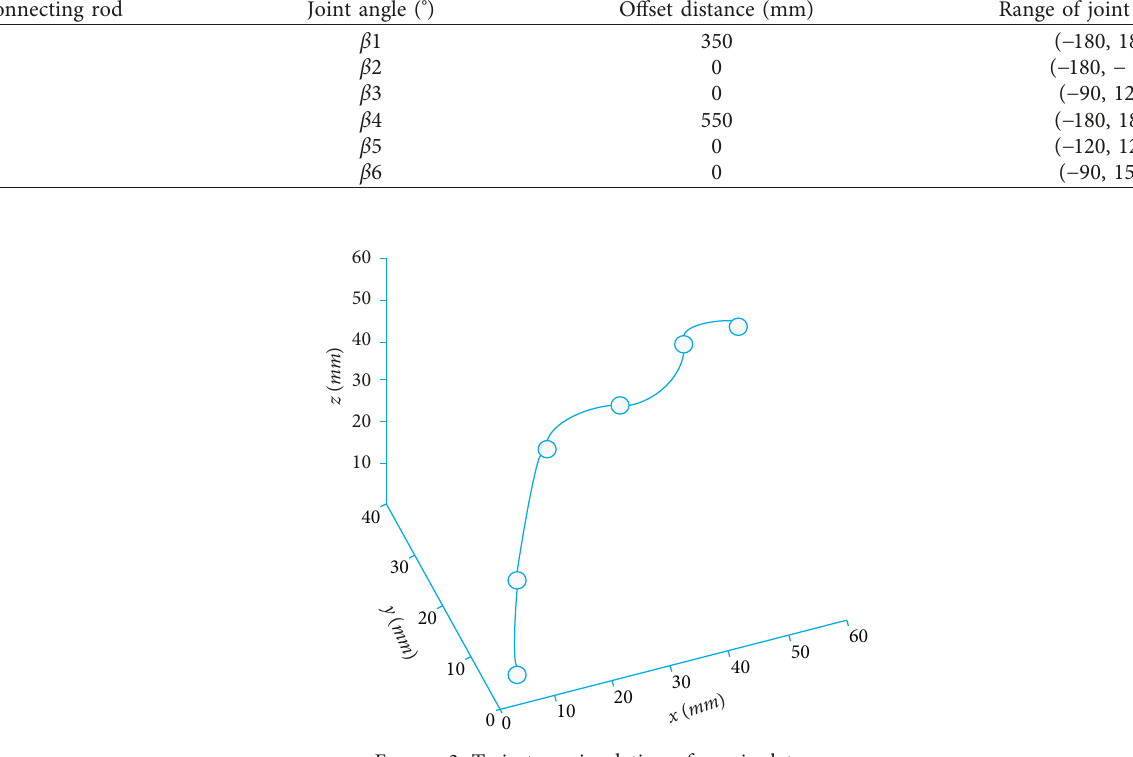
Table 1: D-H parameters of hybrid manipulator.